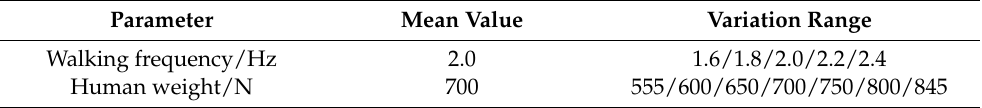
Table 4. Value range of load parameters.